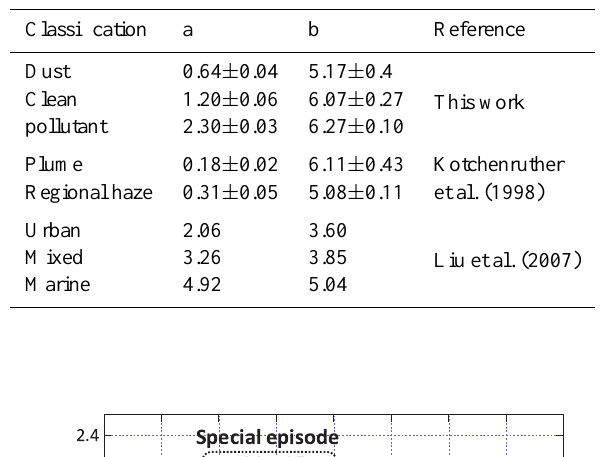
Table 4. Curve-fitting parameters in different aerosol dominant episodes in terms of Eq. (2).